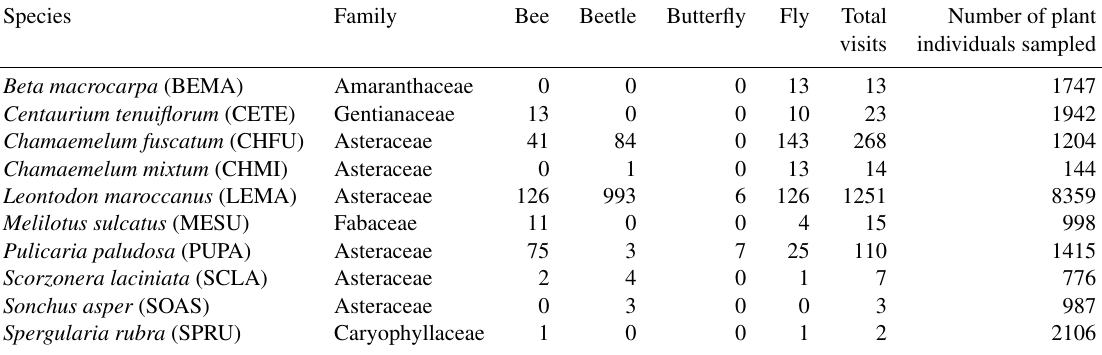
Table 1. Plant species (with code) present in the Caracoles field site receiving pollinator visits during 2020. Specifically, the number of visits of each pollinator group to each plant species is shown. Note that the abundance of each plant species that we measured at the plot scale is correlated with its natural abundances in the site study at larger scales. Information with the 23 plant species present, including those not visited by any pollinator, is in Table A1, Appendix